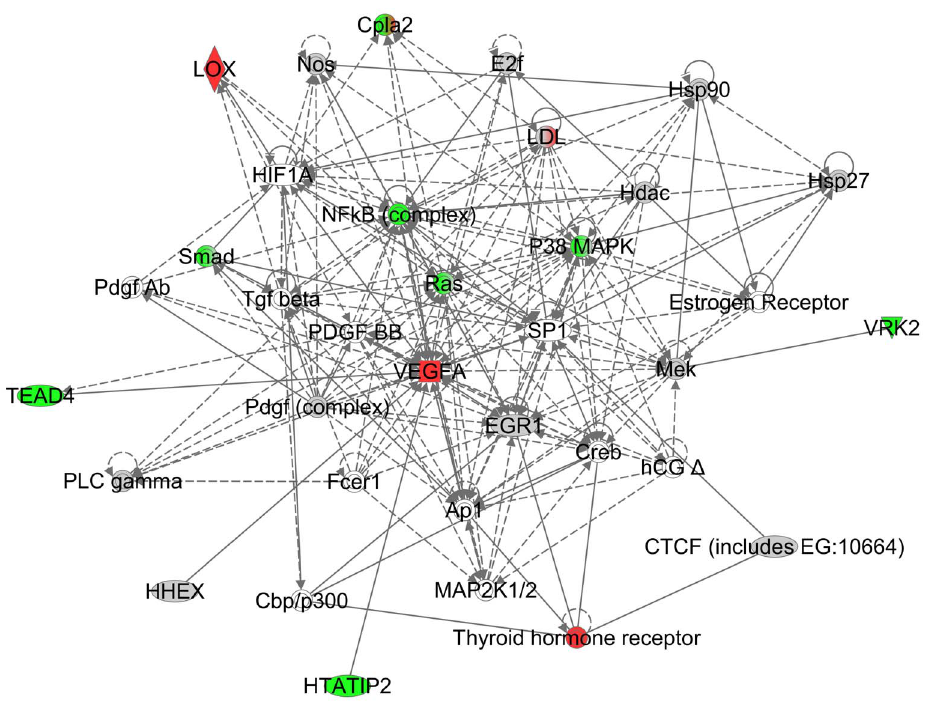
Figure 7. IPA network of angiogenesis-related genes. Node color represents the expression status based on Affymetrix U133A data set (Red: Upregulated in old GBMs, Green: Downregulated in old GBMs, Gray: Baseline, White: Unknown, Mix of green and red: both upregulated and downregulated genes in the complex).